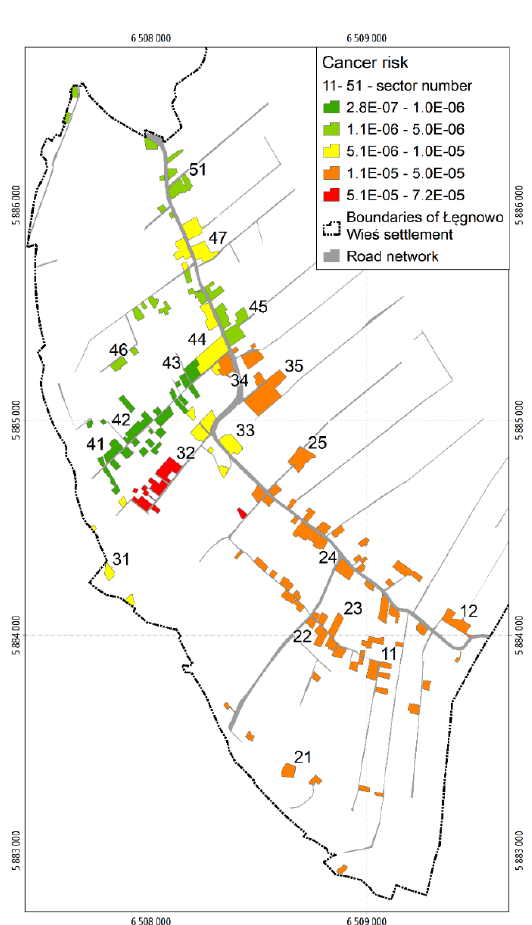
Figure 6. Map of total cancer risks in sectors .